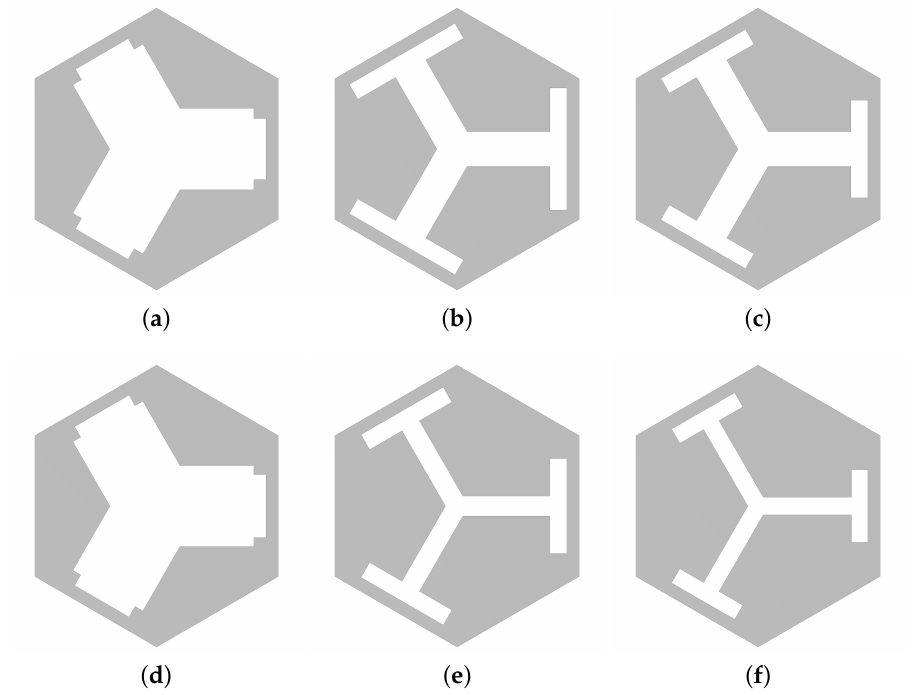
Figure 9. The shapes of the ground-truth ( a – c ) unit cells from the dataset and the predicted unit cells ( d – f ), for the three case studies. ( a , d ) Case 1. ( b , e ) Case 2. ( c , f ) Case 3. Note that they were scaled to the same size in the figures, while they had different lattice